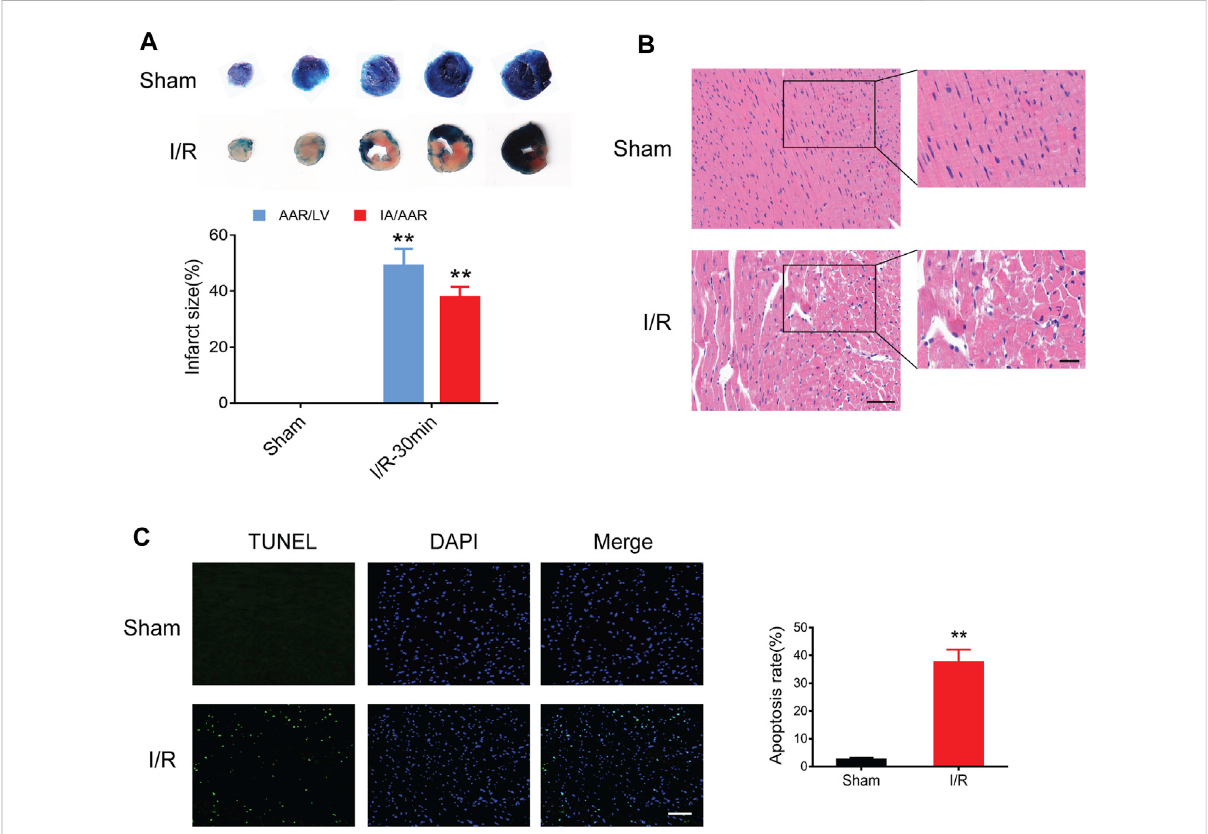
FIGURE 5 Myocardial I/R injury in mice. (A) Evans blue/TTC staining showing myocardial infract size in the sham and I/R groups. (B) HE staining showing myocardialhistologicaldamage.Scalebar=100 μ m(left)and50 μ m(right). (C) TUNELstainingshowingtheapoptosisrateinthemyocardium.Scale bar = 100 μ m n = 3. ** p < 0.01 vs. the sham group. I/R, ischemia reperfusion; AAR, area at risk; IA, infarct area; LV, left